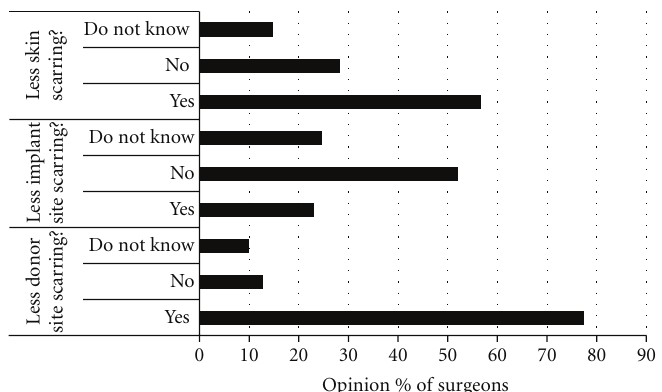
Figure 2: Graph to demonstrate the % of surgeons who believe that using a tissue-engineered ligament would produce less scarring in relation to location in the